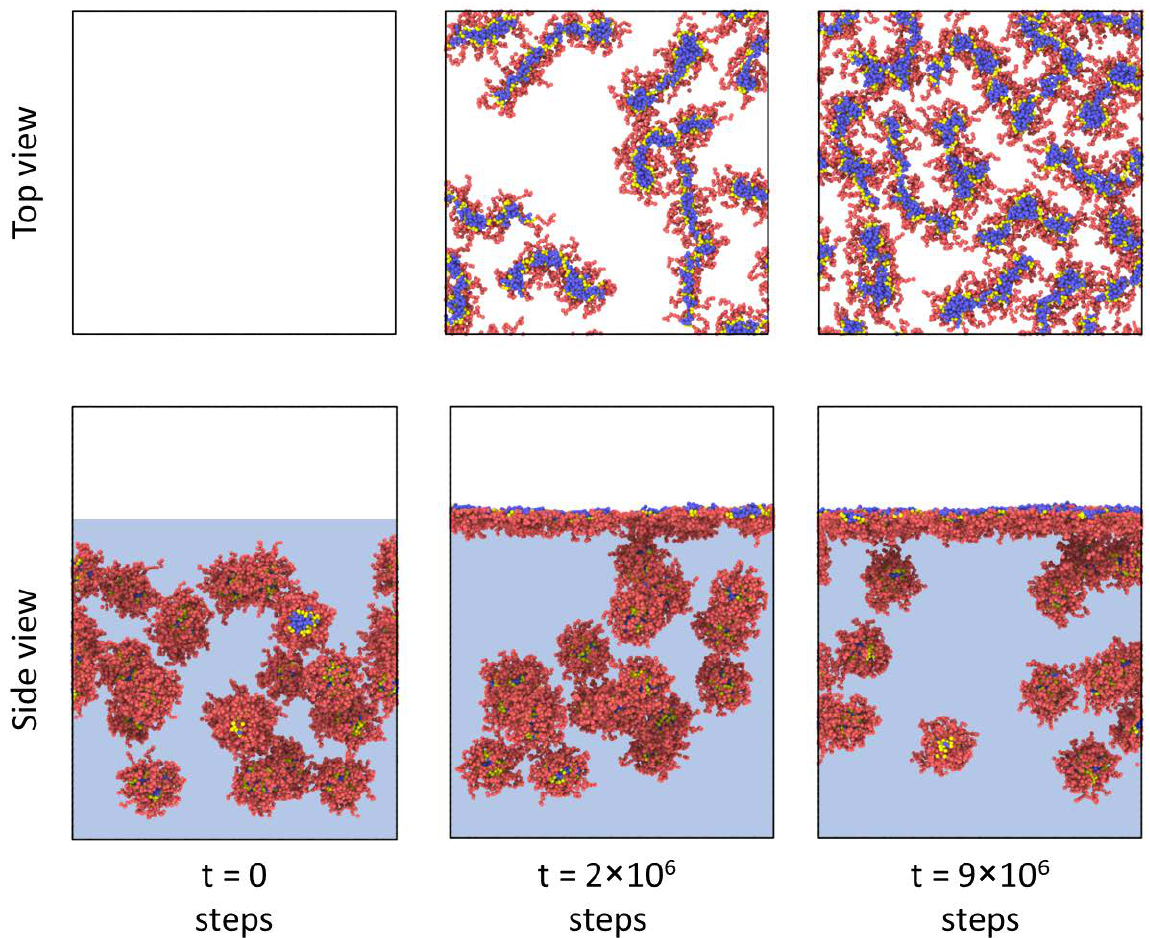
Figure 2. Snapshots depicting an amphiphilic bottlebrush solution at various stages of adsorption to the liquid interface. The macromolecular architecture parameters are: n b = 3, n bb = 100, and f a = 0.5. For convenience, the solvent beads are not